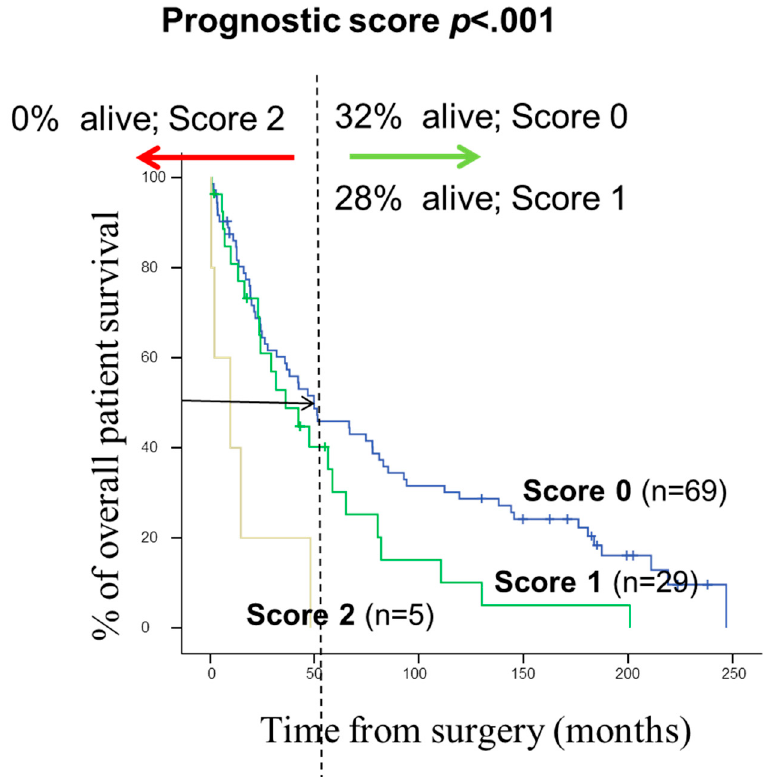
Figure 4. EGFR amplification detected in primary tumors from patients with pulmonary SCC by FISH techniques which showed a significant impact on overall survival in the univariate analysis: ( A ) all patients and ( B ) only in early stages: pT1–pT2 patients. Survival information was available for 103 cases.